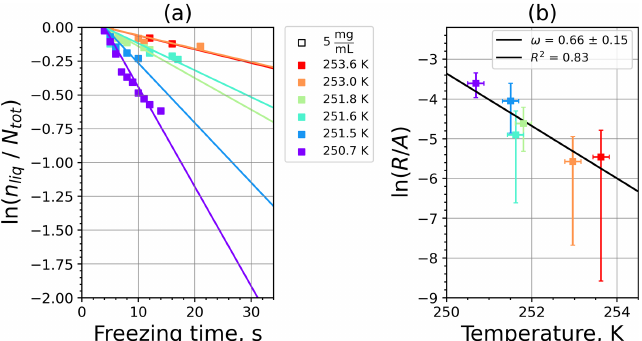
Figure A9. (a) The decrease in fraction of droplets which remained liquid with time at different temperatures in the isothermal experiments for montmorillonite at the M-WT. The colors correspond to different temperatures (particle concentrations of 5gL − 1 ). Typical error bars are depicted in Fig. 6. (b) Freezing rate of montmorillonite normalized to surface area as a function of temperature.